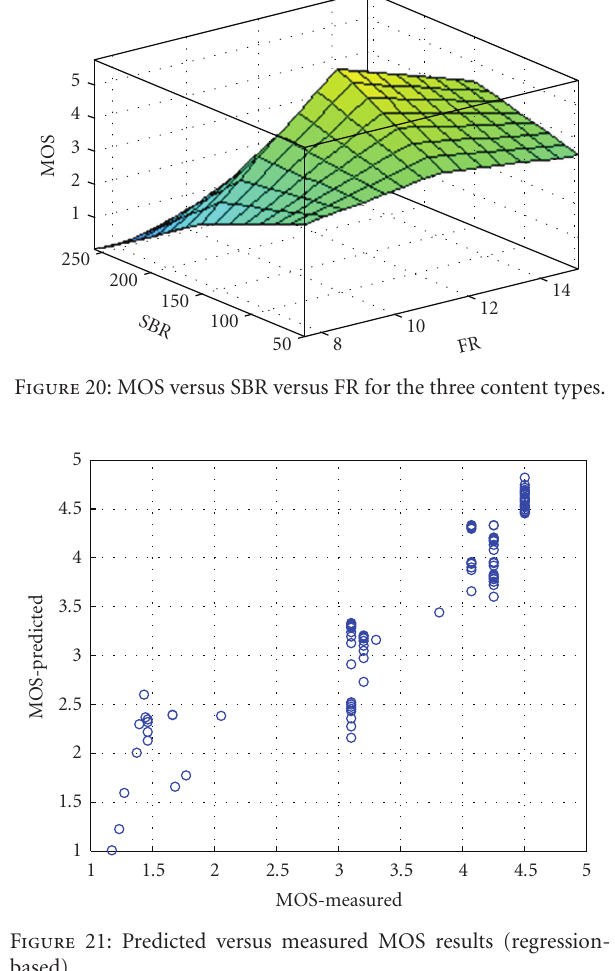
Table 6: Comparison of the